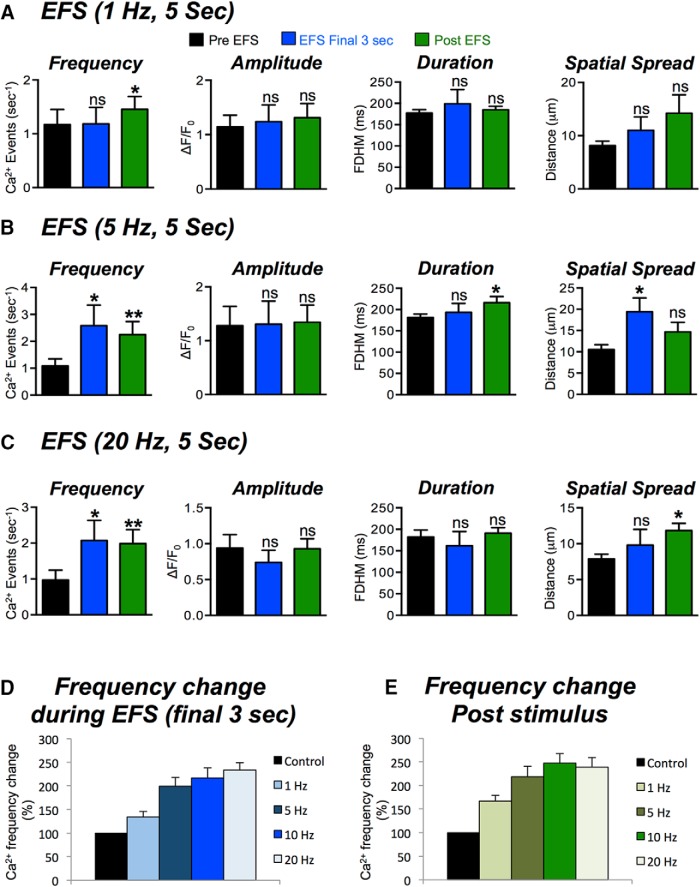
Frequency dependence of Ca2+ transient responses to EFS. A, Summary data showing the excitatory effects of EFS (1 Hz for 5 s) on Ca2+ transients in ICC-DMP during the final 3 s of EFS and during the poststimulus period (5 s following termination of EFS). Ca2+ transient parameters shown include: frequency (s−1), amplitude (ΔF/F0), duration (FDHM), and spatial spread (μm) of Ca2+ transients. B, Summary data showing the effects of EFS (5 Hz; 5 s) on Ca2+ transient parameters. C, Summary data showing the effects of EFS (20 Hz; 5 s) on Ca2+ transient parameters. D, Percentage (%) change of Ca2+ transient firing frequency at all frequencies of EFS tested (1–20 Hz; net percentage change normalized to control) during the final 3 s of EFS and during the poststimulus period. E, Note the frequency-dependent effects of EFS on Ca2+ transient responses. Summary data in all panels shows the include 5 s before EFS, the final 3 s during EFS and 5-s post-EFS; ns = p > 0.05, *p < 0.05, **p < 0.01.